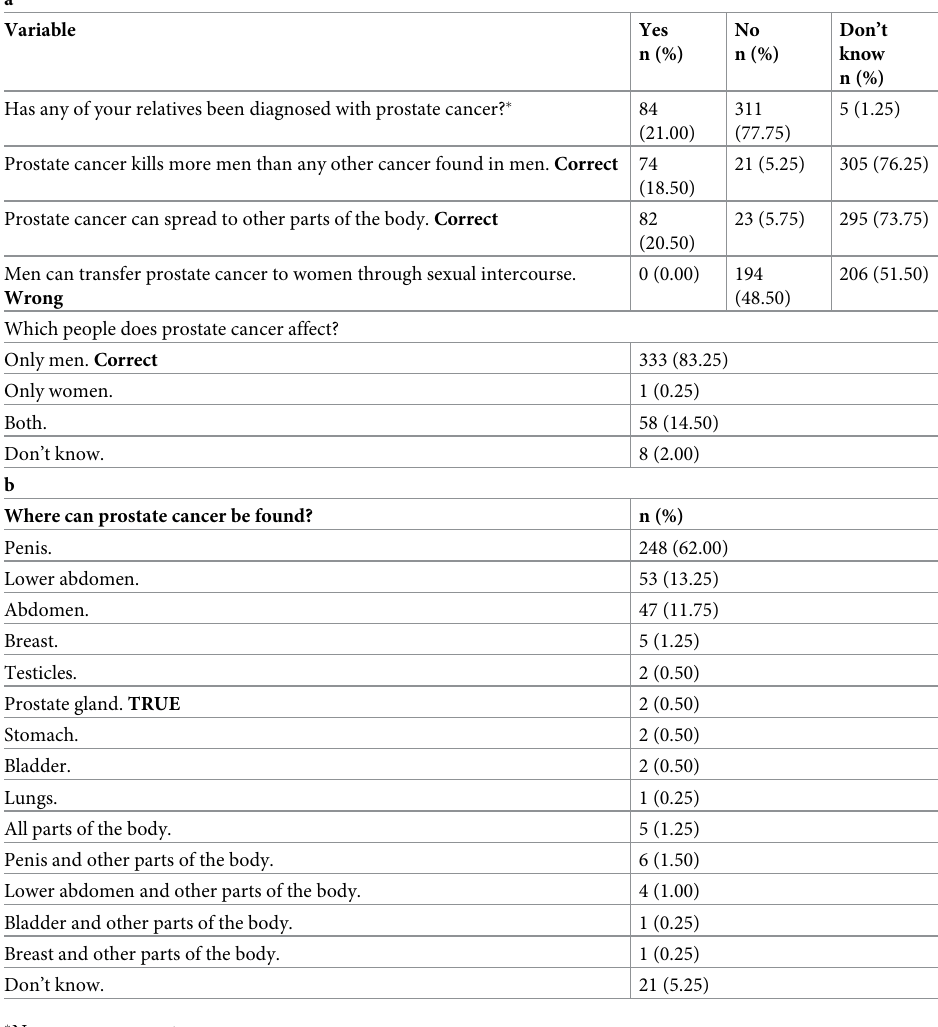
Table 3. Awareness about prostate cancer (n =